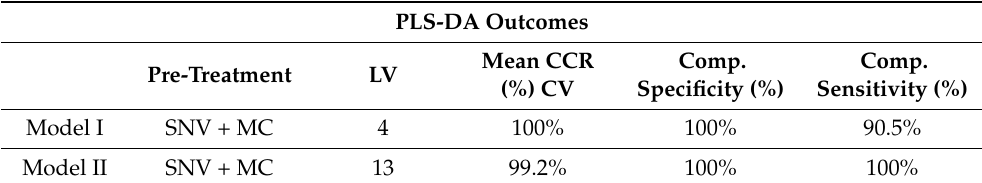
Table 1. Summary of the PLS-DA outcomes for both Model I and Model II. The optimal pre-treatment, the optimal number of latent variables (LV), the percentage of mean correct classification rate in cross-validation (CCR(%) CV), as well as the predicted specificity and sensitivity for the Compliant class (Comp. specificity; Comp sensitivity), are